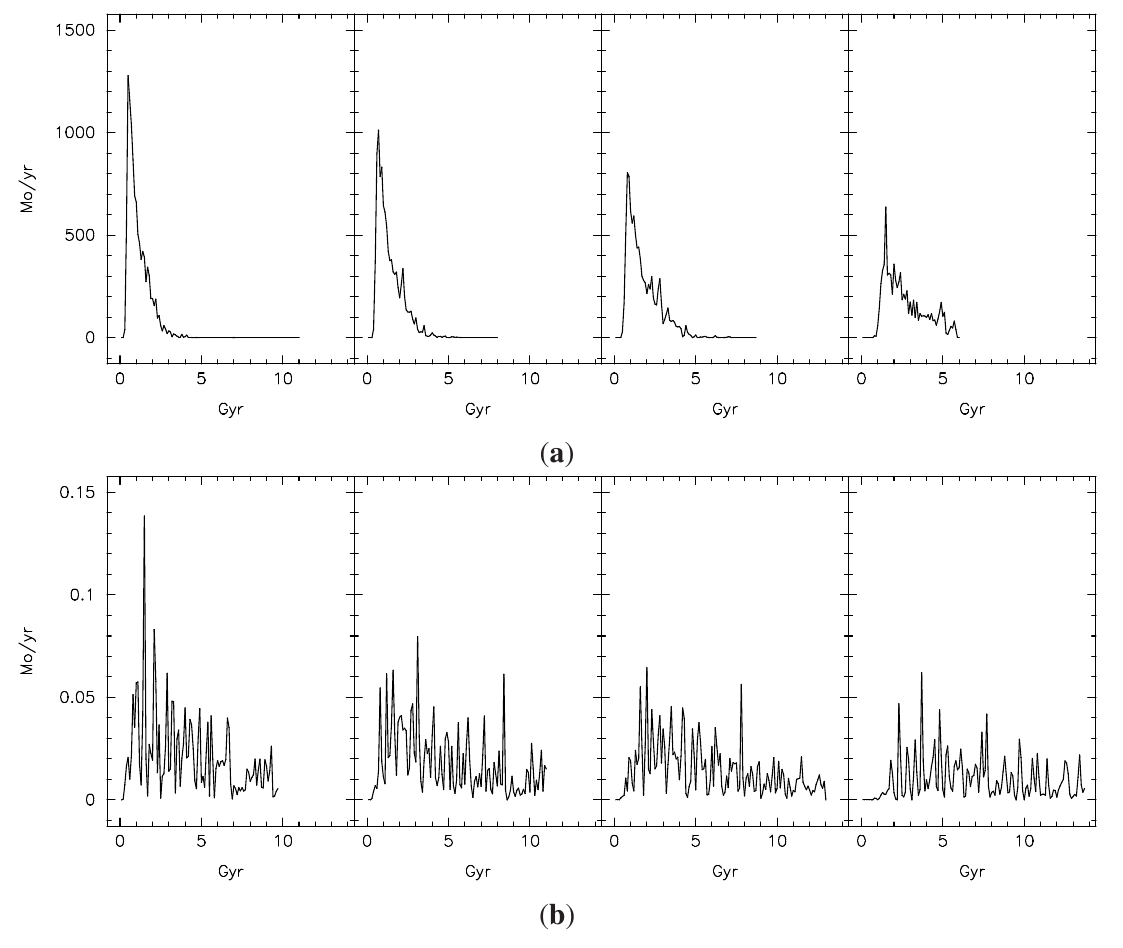
Figure 10. The SFR versus time for the models of [1] framed in the Λ -CDM model of the Universe and with fully cosmological initial conditions. The input data and parameters for these models are described in the text and listed in Table 1. The SFR is in solar masses per year and the time is in Gyr. Left to right: high density, intermediate density, low density, very low density. ( a ) high masses; ( b ) low masses. Reproduced with permission from [1]. Copyright 2012 John Wiley &